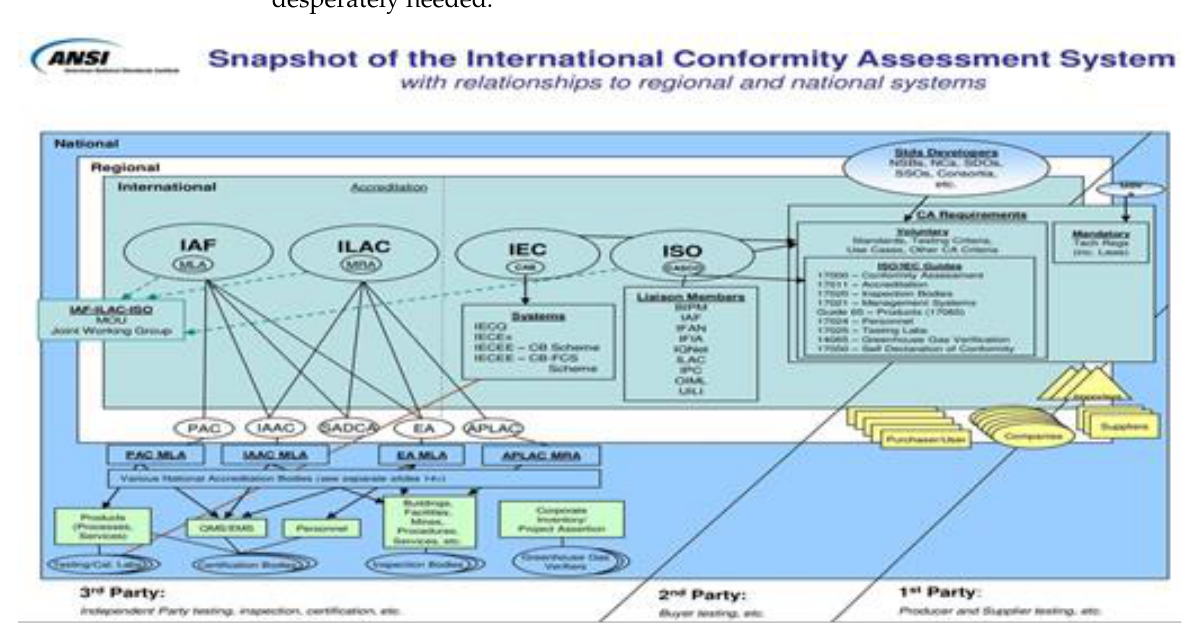
Figure 1. International Conformity Assessment System Source: American National Standards Institute (2022) .